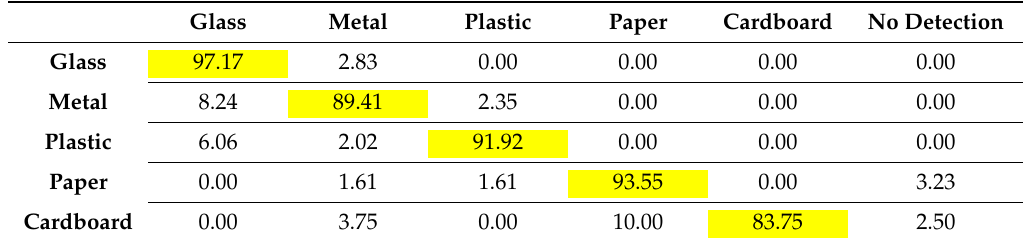
Table 2. Faster R-CNN–Inception-ResNet Confusion matrix.